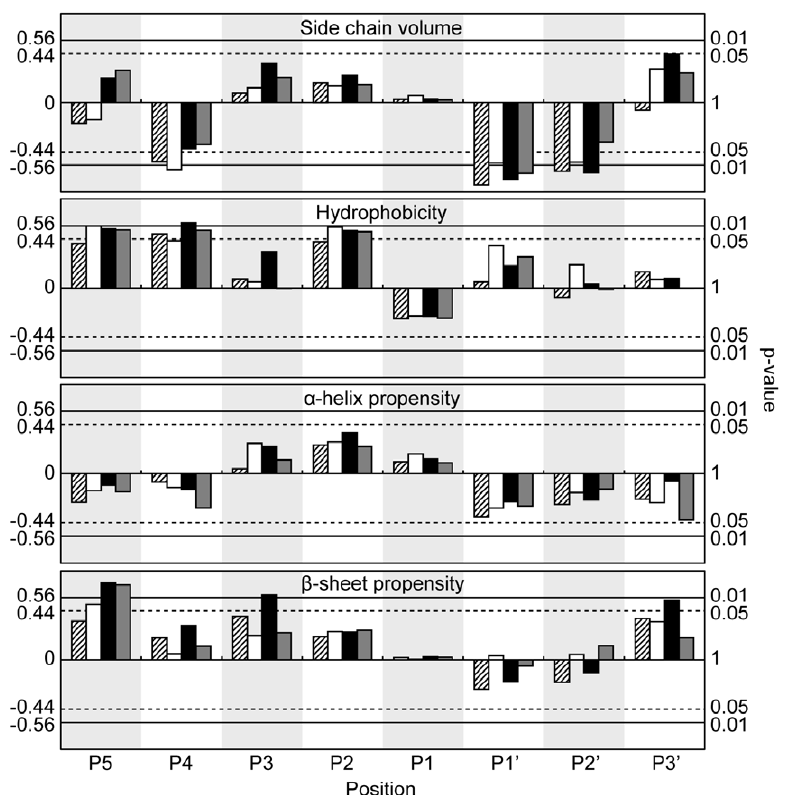
Figure 2. Correlation between 3CL pro activities and structural properties of substituting residues. The relative protease activities of 3CL pro from HCoV-NL63 (shaded, group 1), HCoV-OC43 (white, group 2a), SARS-CoV (black, group 2b) and IBV (grey, group 3), were correlated with structural properties of substituting residue properties, including side chain volume [28], hydrophobicity [29] and a -helix and b -sheet propensities [30]. Correlation coefficients of + / 2 0.56 and + / 2 0.44 correspond to p-values of 0.01 and 0.05 respectively.